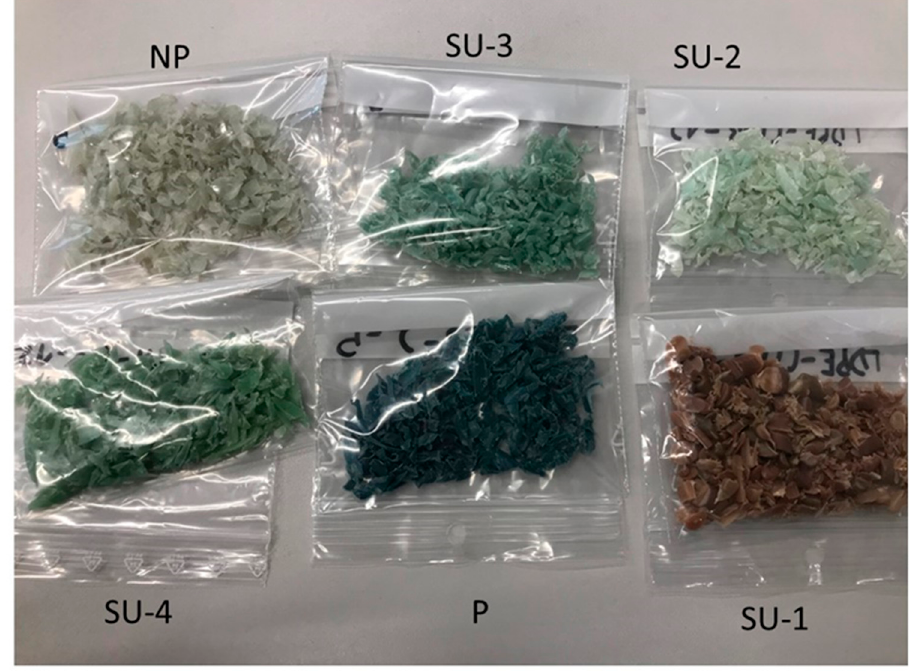
Figure 5. The recyclates of the six scaled-up samples after extrusion .